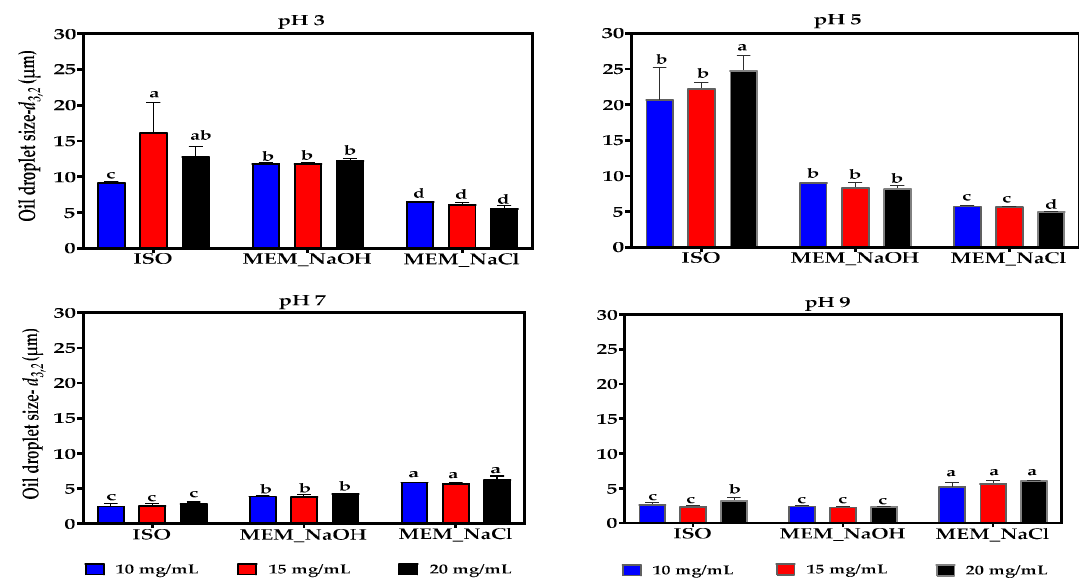
Figure 7. Effect of pH and protein concentration on the oil droplet sizes ( d 3,2 ) of emulsions formed by isoelectric pH precipitated isolate (ISO) and membrane isolated proteins from alkaline (MEM_NaOH) and salt (MEM_NaCl) solution extracts. At each pH, bars with different letters have significantly different ( p < 0.05) mean values.